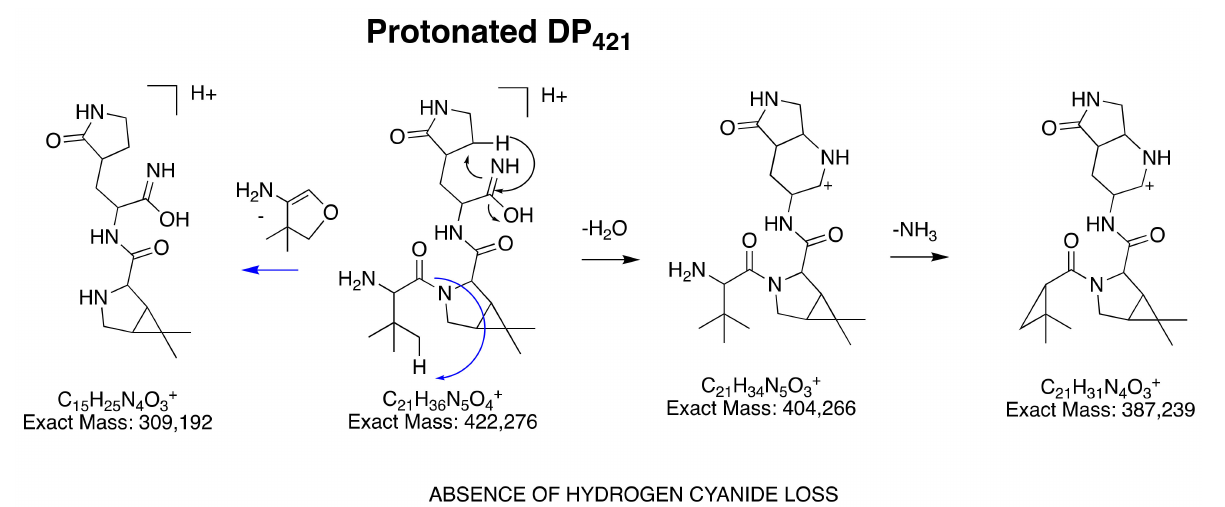
Figure 5. Proposed fragmentation pattern of protonated DP 421 ([DP 421 +H] +